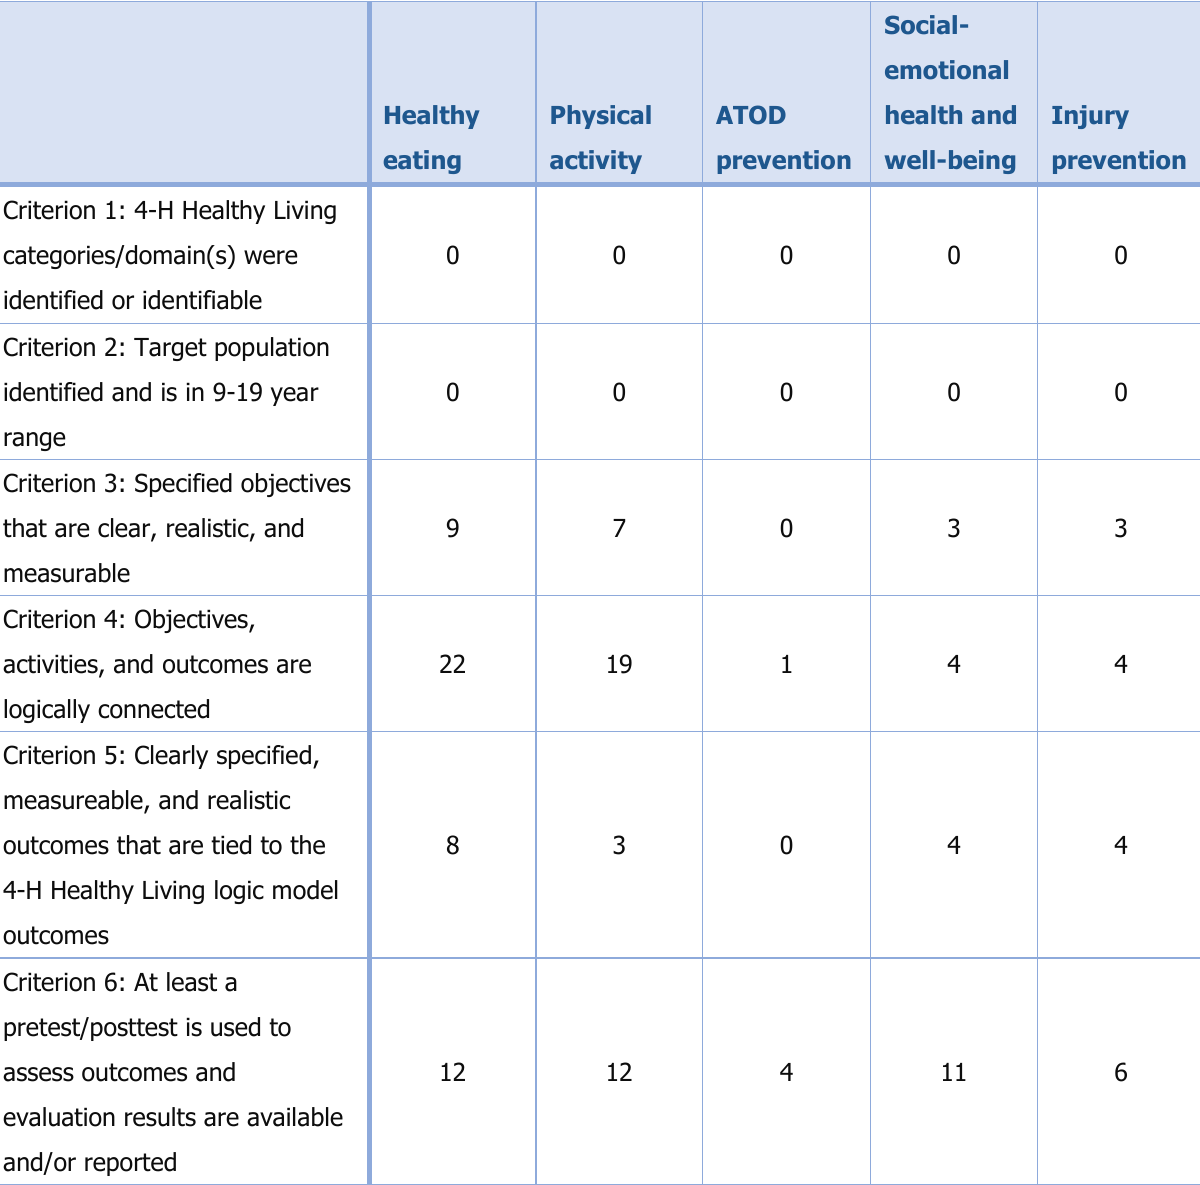
Table 1. Programs with Unmet Screening Criteria within Each 4-H Healthy Living Program